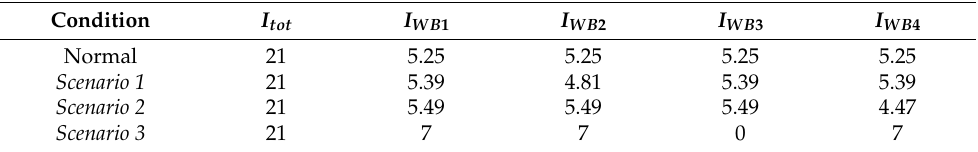
Table 2. Simulation results of the current distribution in wire bonded connection of the power module.